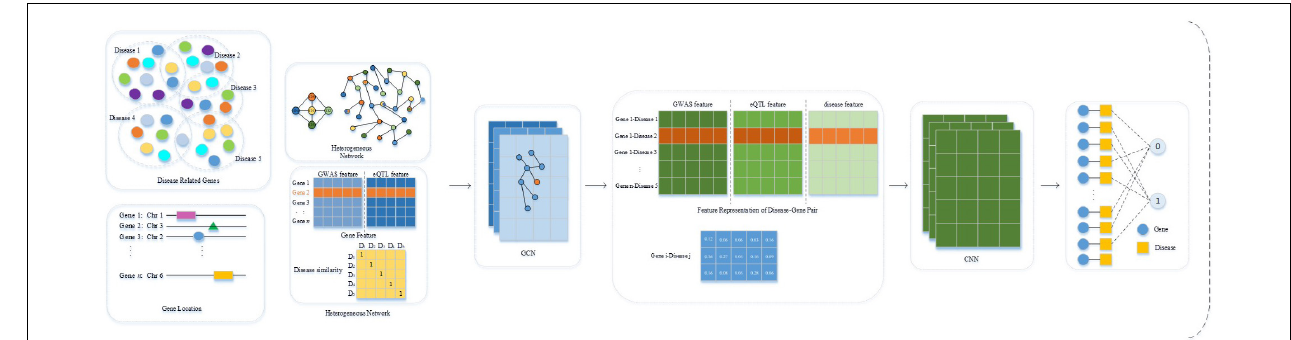
FIGURE 1 | Workflow of